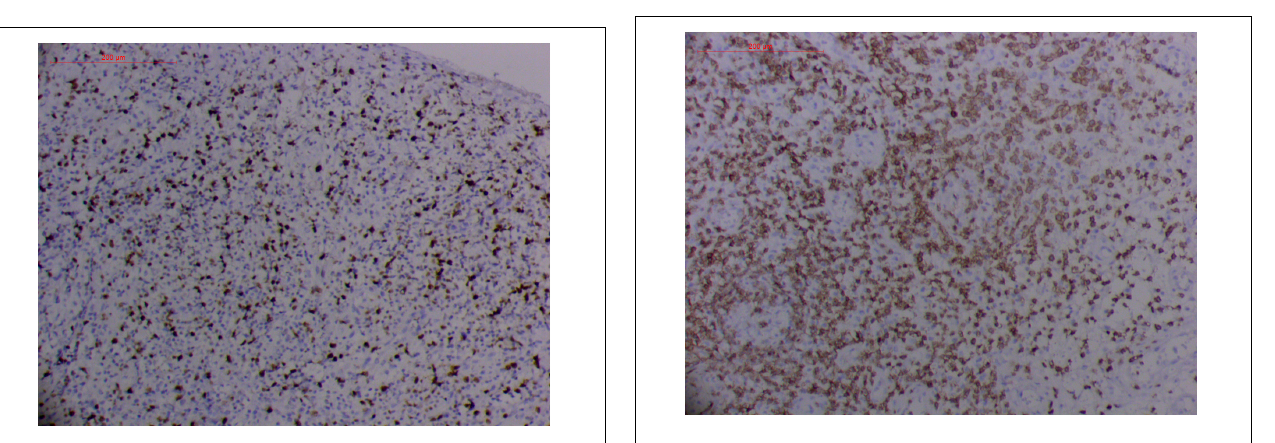
FIGURE 11 | Extranodal natural killer/T cell lymphoma, nasal type/rhino-orbital-cerebral mycosis.” Rhizopus arrhizus -induced positive expression of CD3 from granulomatous tissues (envision method, original magnification ×